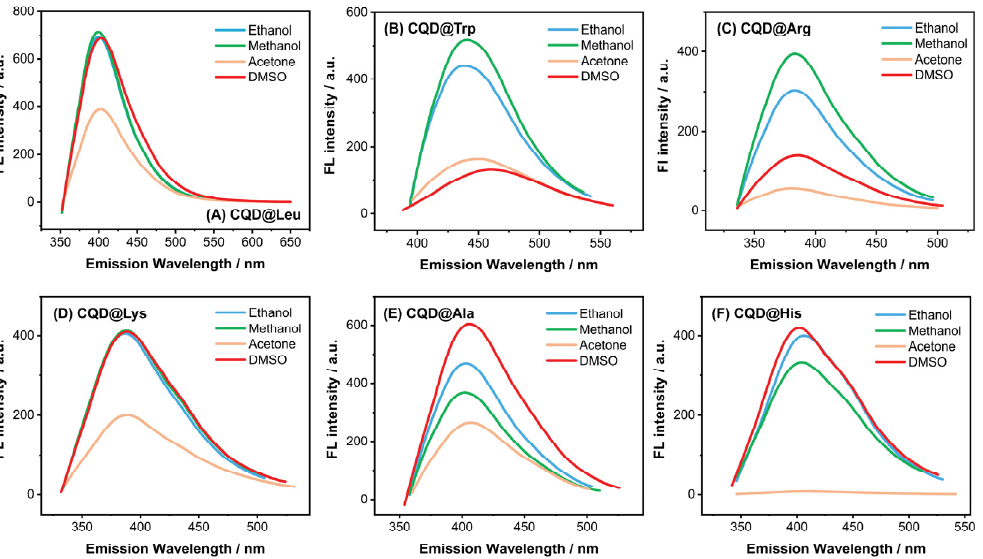
Figure 8. Fluorescence spectra of prepared CQDs in different solvents: ( A ) CQD@Leu, ( B ) CQD@Trp, ( C ) CQD@Arg, ( D ) CQD@Lys, ( E ) CQD@Ala, ( F ) CQD@His recorded at λ EX = 340 nm.